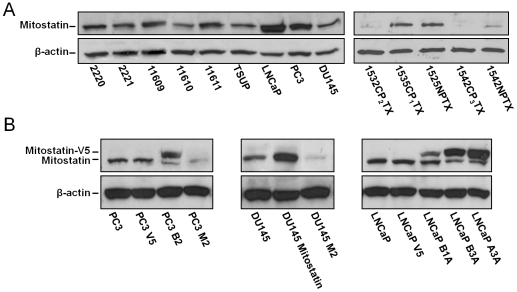
Mitostatin expression in prostate cancer cell lines.
A: Western blot analysis: Mitostatin is differentially expressed in human prostate cancer cell lines. Protein loading was confirmed by reprobing the membrane with antibody to β-actin. B: Western blots showing the expression of Mitostatin in PC3, DU145 and LNCaP cell lines utilized in this study.